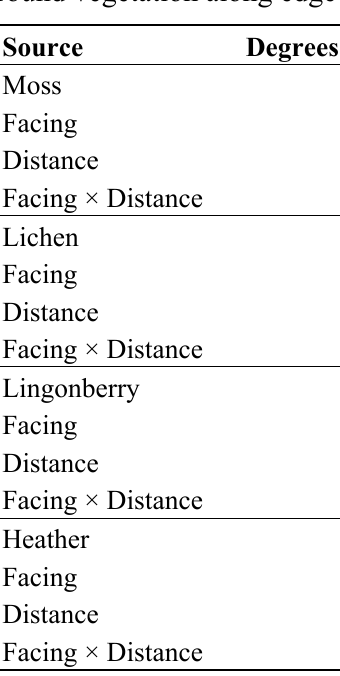
Table 3. The influence of the fixed effects distance from the edge and the aspect of the edge on the ground vegetation along edge